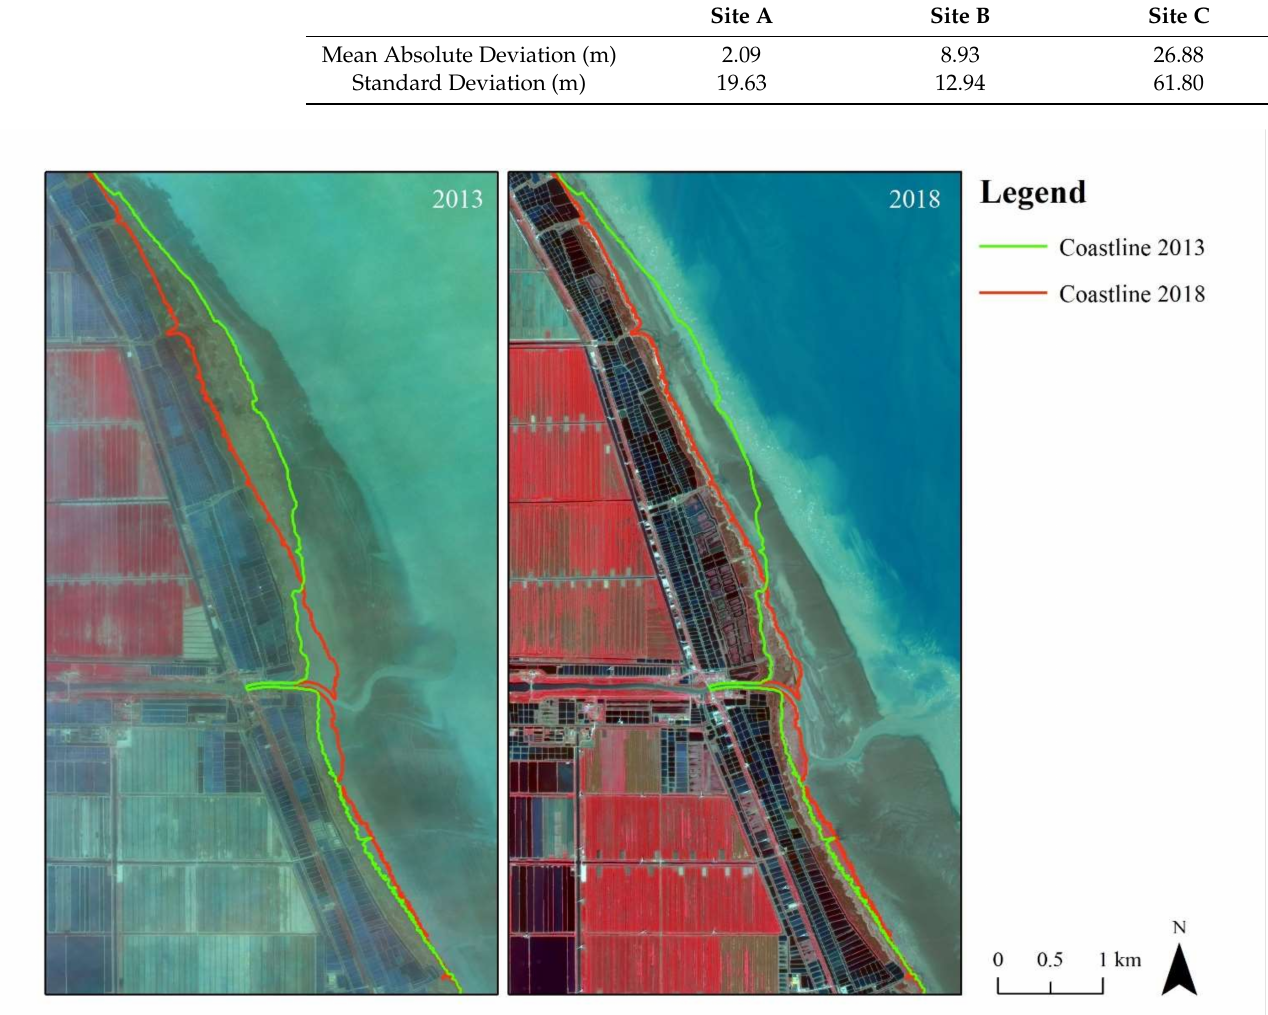
Figure 7. Coastline silt sediment and erosion in Jiangsu